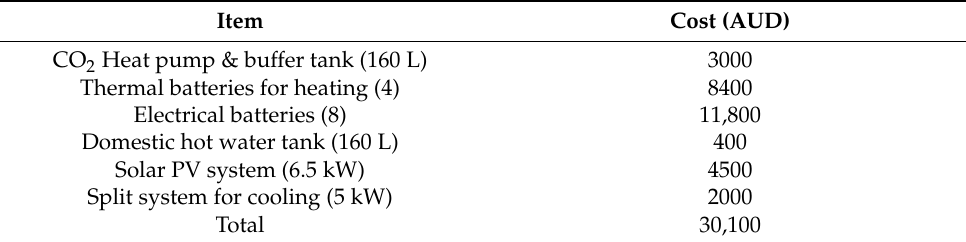
Table 5. System Table 5. System costs.